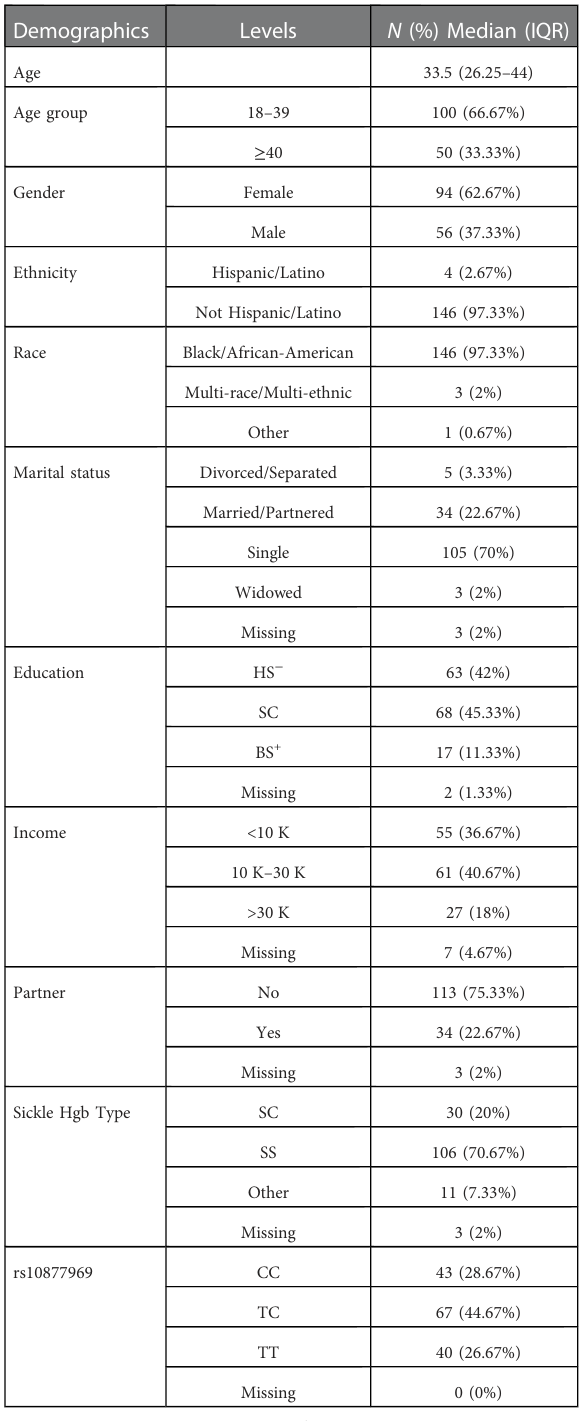
TABLE 1 Demographics and outcome measurements ( N